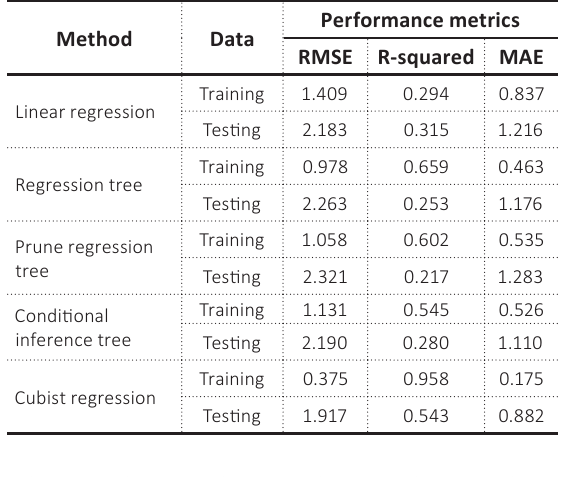
Table 9. Performance metrics for the study methods